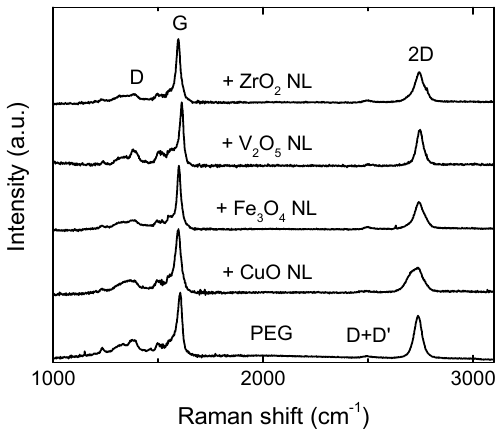
Figure 2. Raman spectra for PEG and after NL decoration.